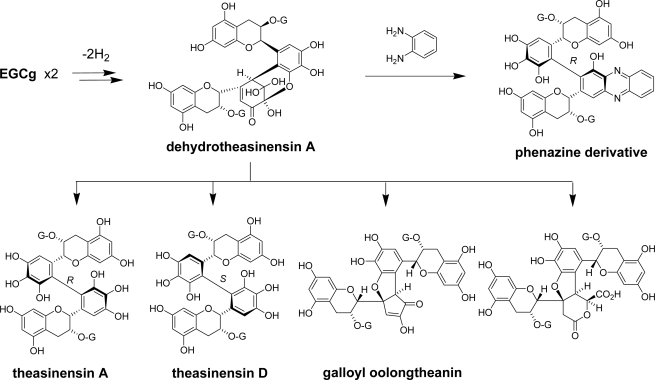
Production and decomposition of dehydrotheasinensin A [33].